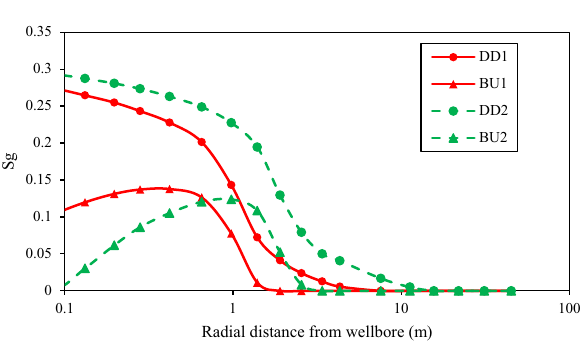
Fig. 5 Gas saturation profile at the end of DDs and BUs below P case 1 (Pi = 34 MPa)